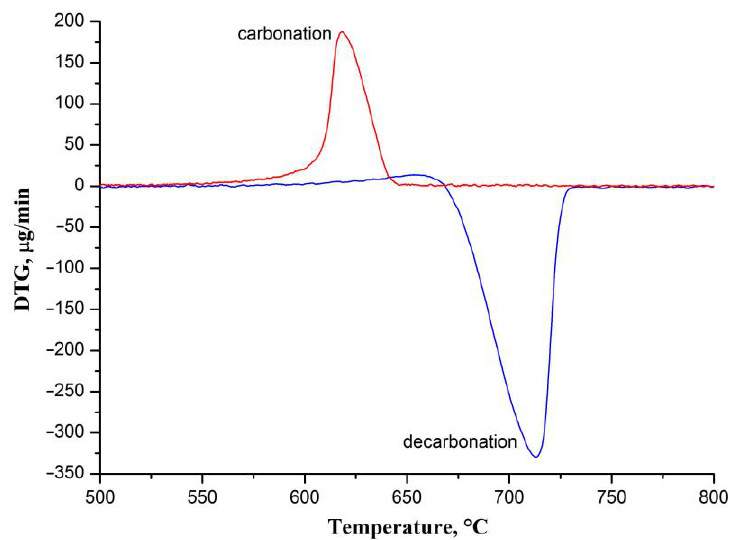
Figure 4. The DTG curves of CaO nanofibers carbonation and decarbonation processes. Figure 5 shows the carbonation–decarbonation cycle profile in the temperature range of 500–800 ◦ C.